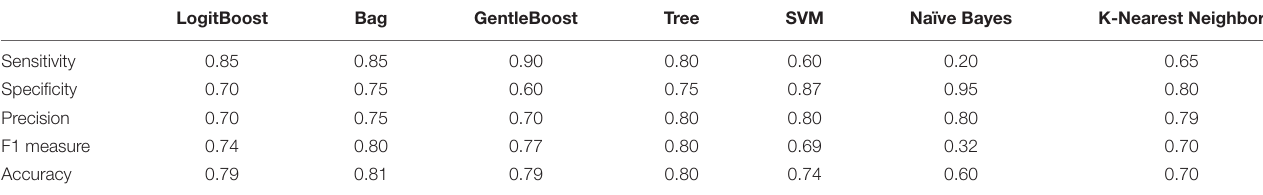
TABLE 2 | Performance evaluation of classification algorithms deploying PD and HC using features extracted via different analytic methods. LogitBoost Bag GentleBoost Tree SVM Naïve Bayes K-Nearest